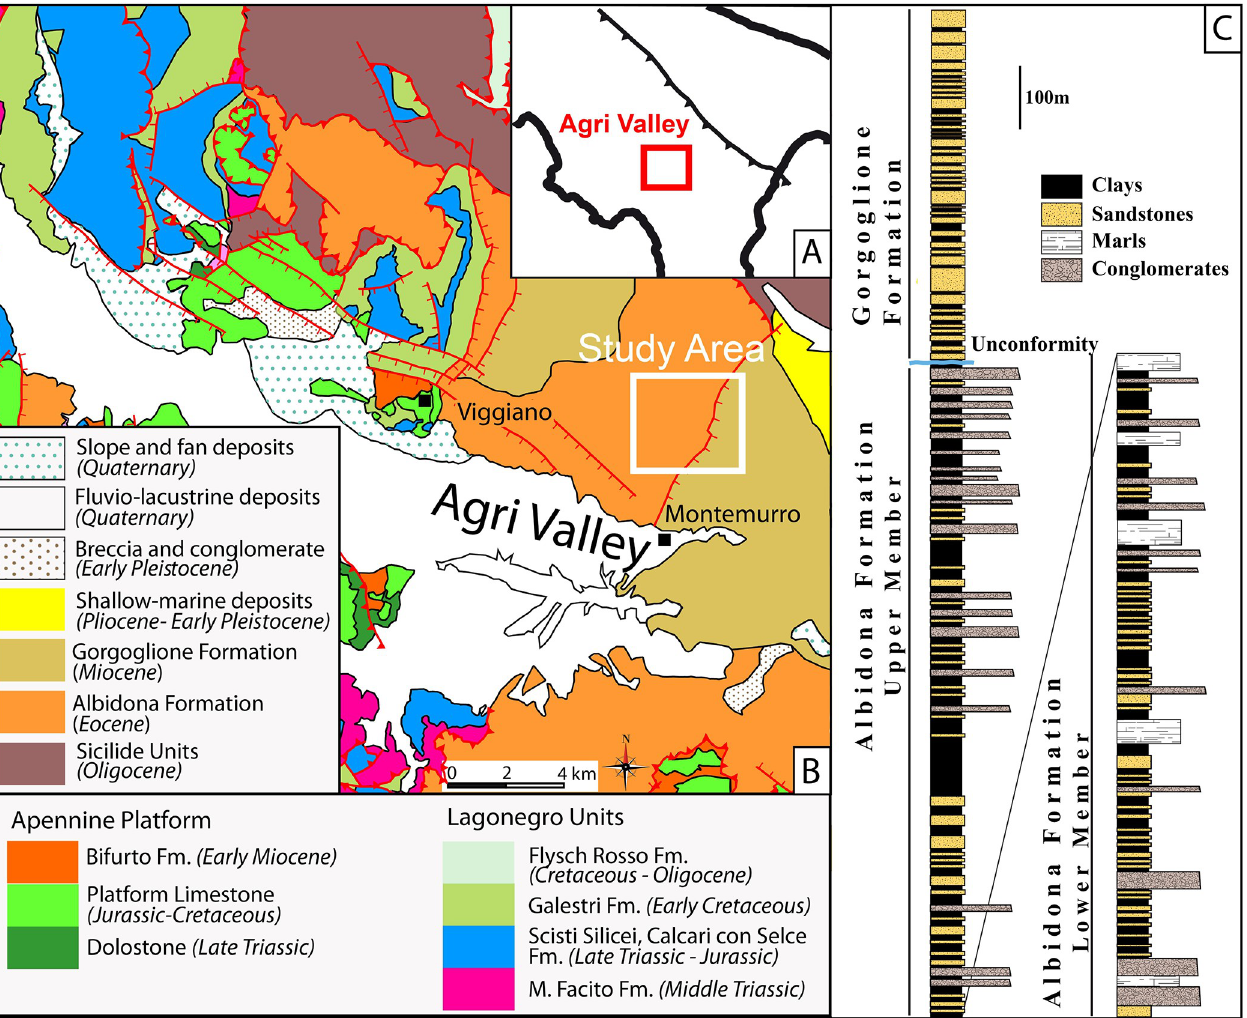
Fig 1. Sketch map of the Southern Apennines (A), schematic geological map of the Agri Valley (B) and stratigraphic column of the Albidona and Gorgoglione Formations (C). After Prosser et al. [26], modified.